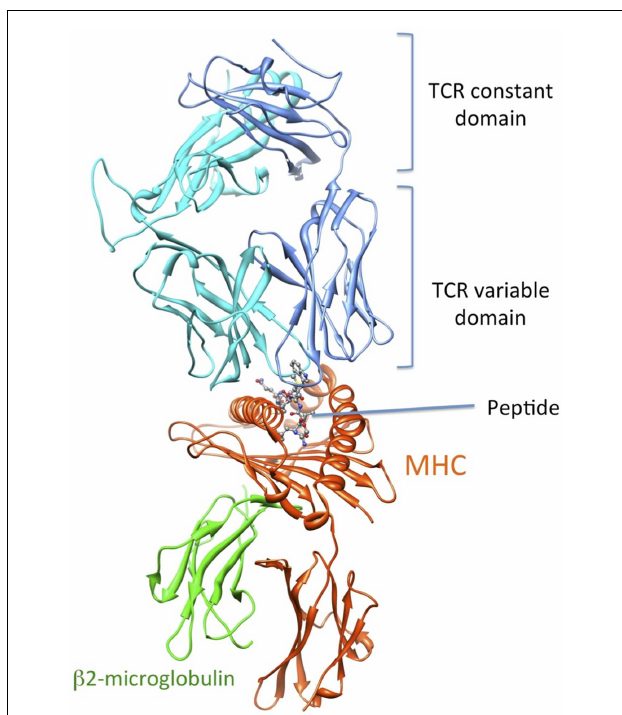
FIGURE 1 | 3D-structure of theTCR-pMHC complex . (1G4TCR bound to NY-ESO-1/HLA-A201, entry 2BNR (124) of the PDB).TCR α ,TCR β , MHC, and b2-microglobulin are colored in blue, cyan, orange, and green, respectively. The NY-ESO-1 peptide is displayed in ball and stick.